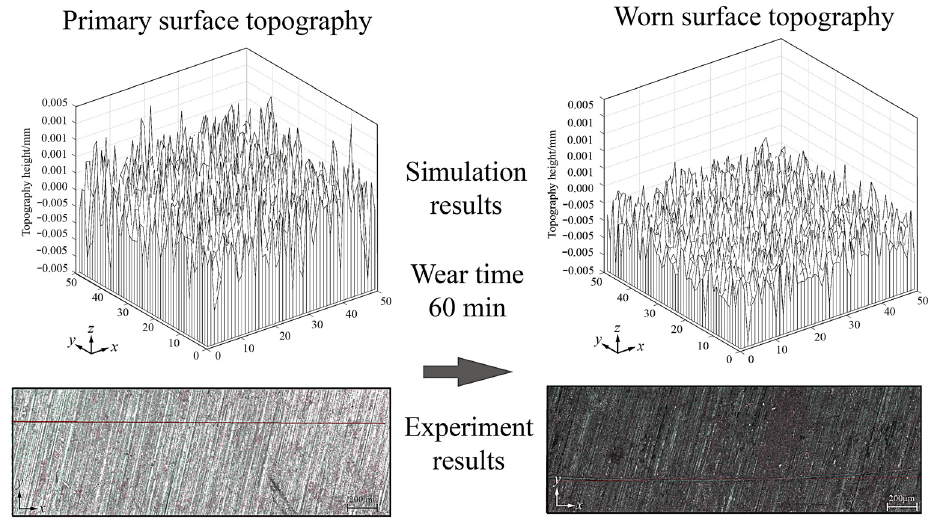
Figure 12. Changes in the surface topography during the wear process.